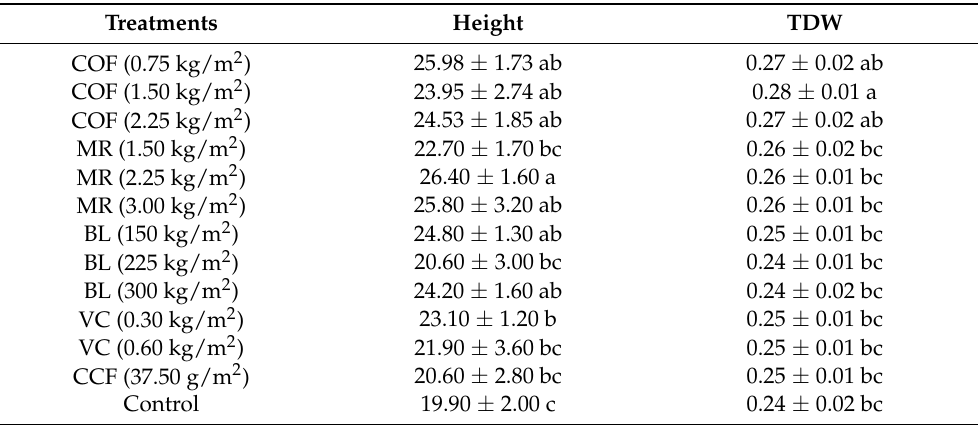
Table 5. Effect of different biological organic fertilizers and chemical fertilizer on the height and total dry weight of maize